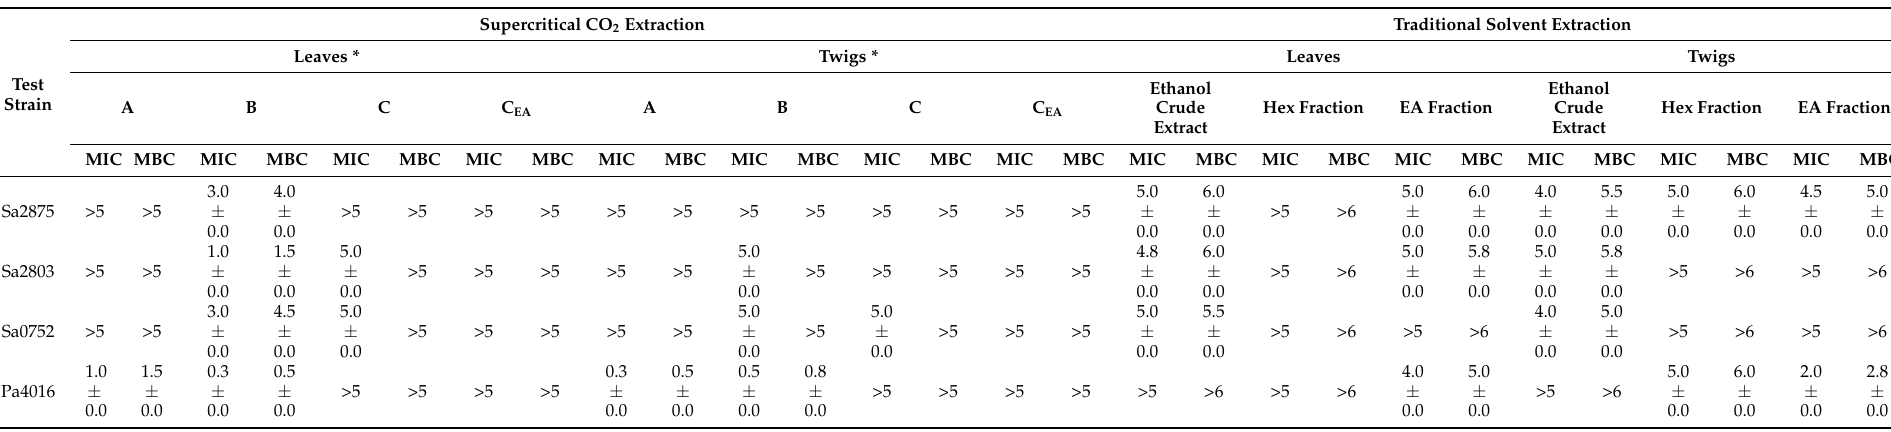
Table 3. Minimum inhibitory concentrations (MIC, mg/mL) and minimum bactericide concentration (MBC, mg/mL) of the various extracts of Illicium verum .